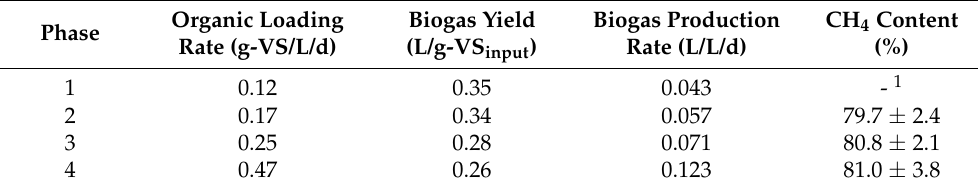
Table 3. WAS digestion performance of the reactor during each